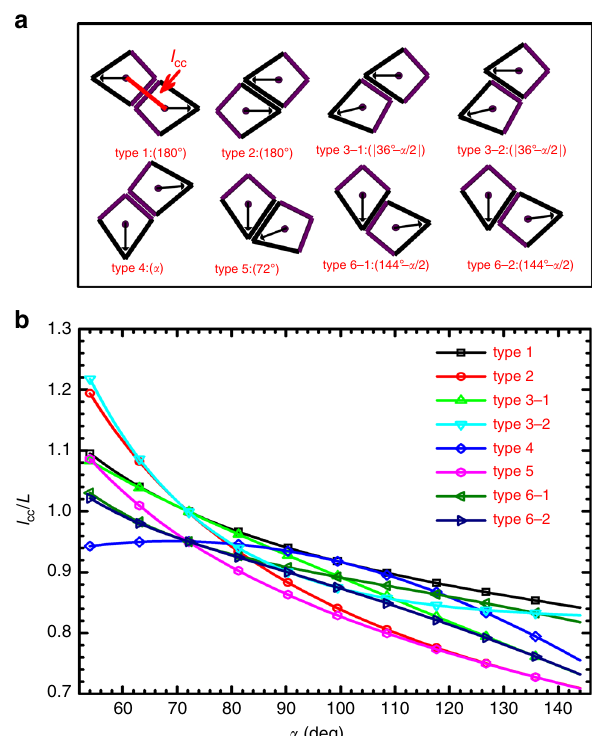
Fig. 4 LPC-NPPs model. a Schematic graphs showing six types of LPC- NPPs. Numbers/expressions in parentheses show corresponding relative pointing angles ϑ . Note that for type 3 and type 6, one particle can slide relative to the other along the contacting edges while keeping the contact length maximized. In the graph, two cases for type 3 and type 6 are illustrated, corresponding to when the 72° vertex and the α vertex of one particle coincide with one of the non-72° and non- α vertices of the other particle, respectively. b Dimensionless center-to-center distance l cc / L of LPC-NPPs shown in a for kites with different α